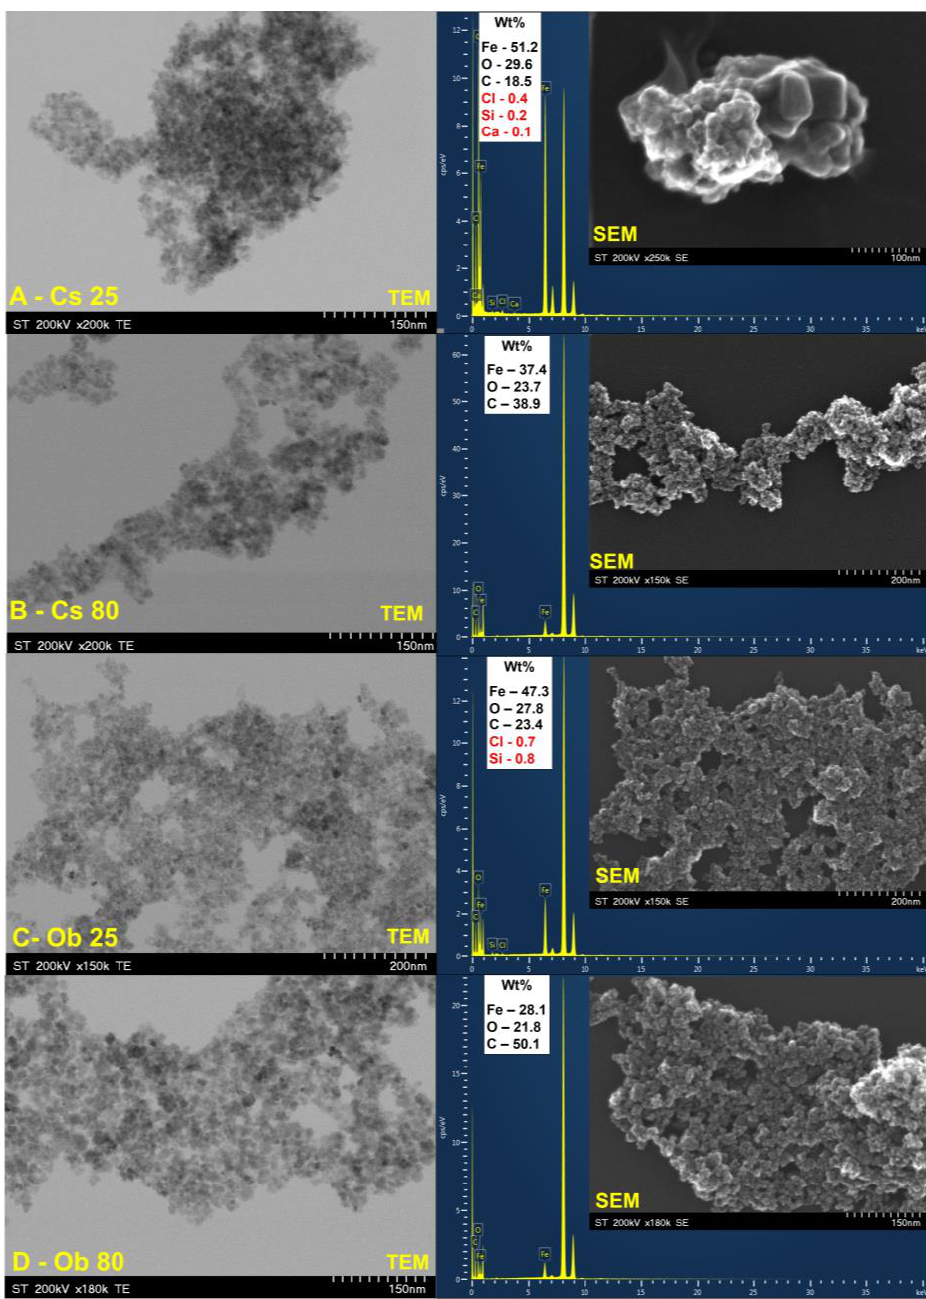
Figure 5. TEM and SEM images alongside EDX spectrum of MNPs obtained by green synthesis from Cs ethanolic extract at 25 °C ( A ) and at 80 °C ( B ), as well as from Ob ethanolic extract at 25 °C ( C ) and at 80 °C ( D ).